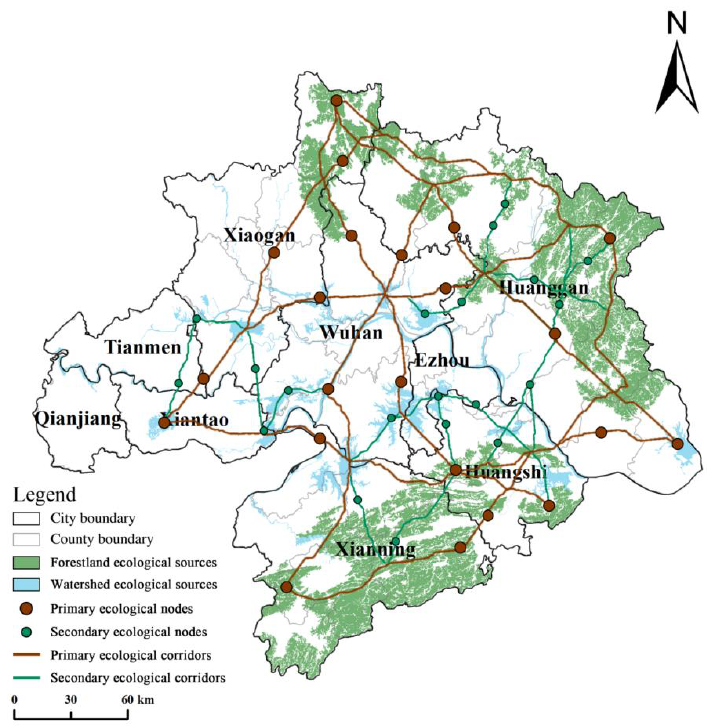
Figure 10. The WUA landscape pattern optimization network.